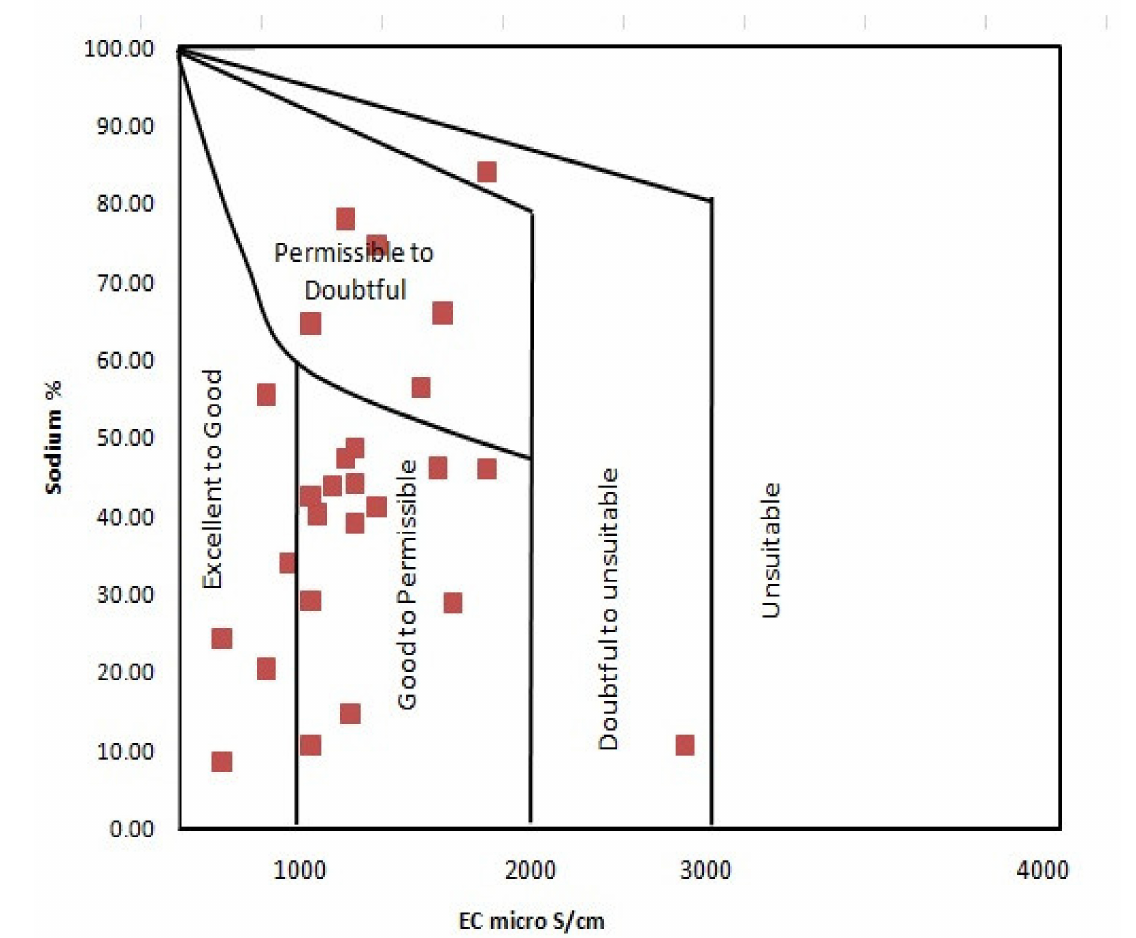
Figure 8. Wilcox diagram for percent sodium (Na%) against